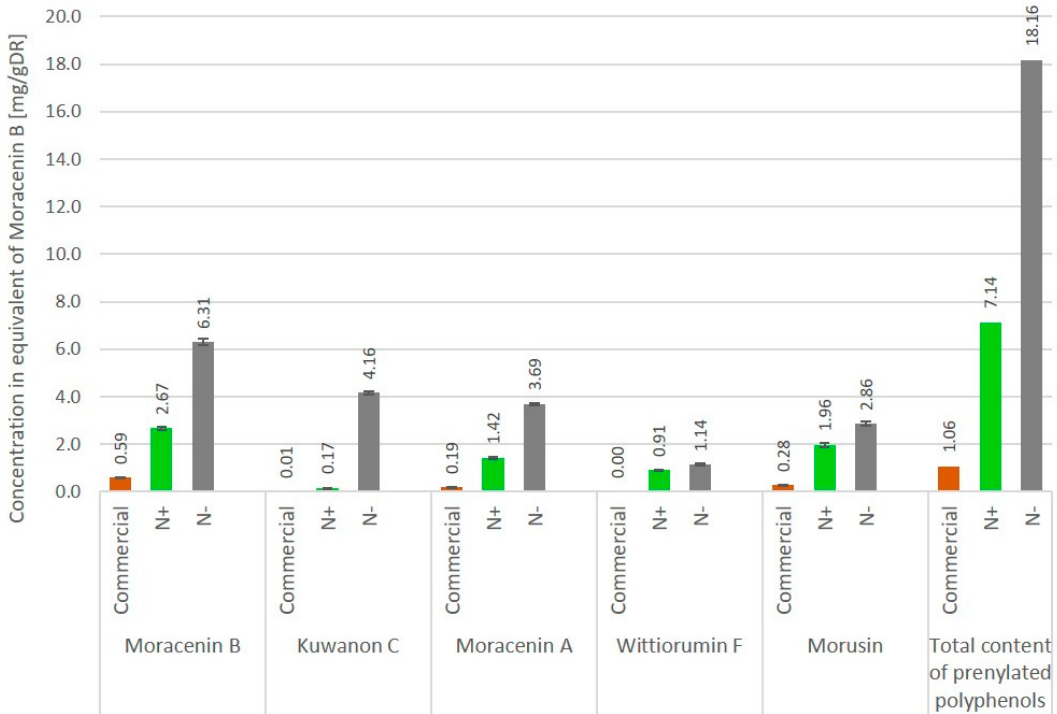
Figure 4. Concentration of metabolites in Morus. alba L. roots cultivated under aeroponic soil-less conditions with and without nitrogen deficiency (N- / N + respectively) and commercially available roots. Concentrations are expressed as the quantity of individual markers per 1 g of dry root powder, mg / gDR ( n = 3).